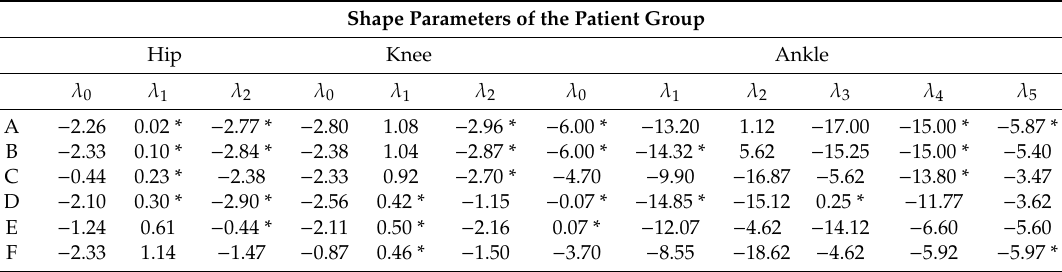
Table 4. Shape parameters of the patient group of three